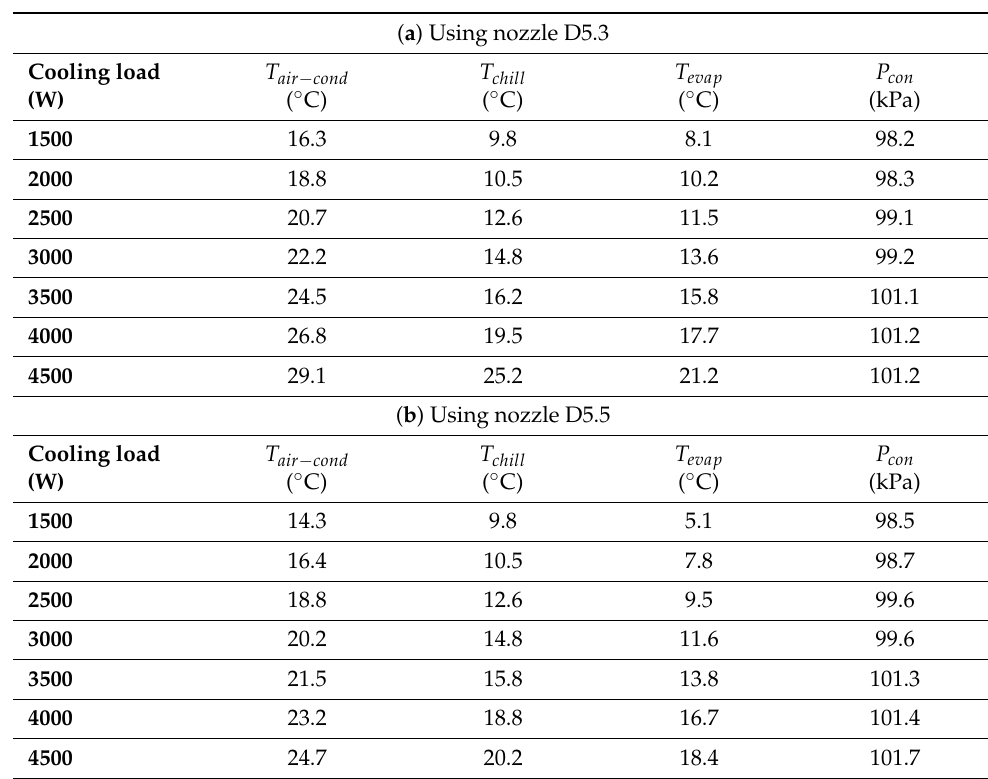
Table 2. The temperature and pressure at points of interest. ( a ) Using nozzle